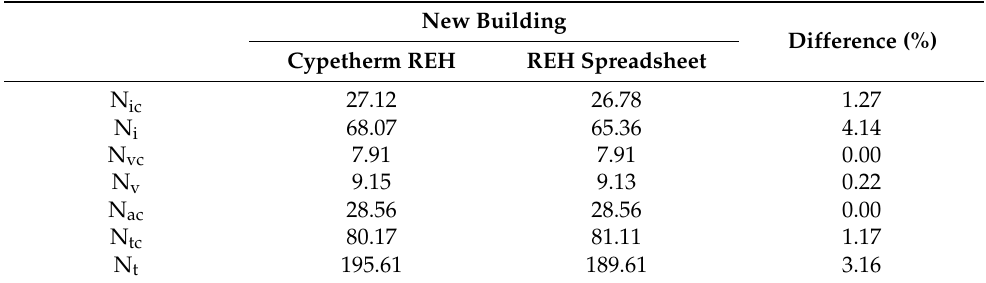
Table 6. Comparison between the Cypetherm REH results and REH spreadsheet results—new